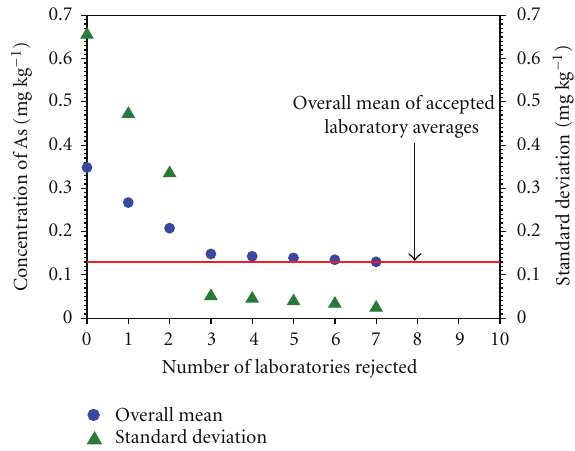
Figure 4: Changes of the overall mean and its standard deviation for As in INCT-PVTL-6 observed while executing the outlier’s rejec- tion